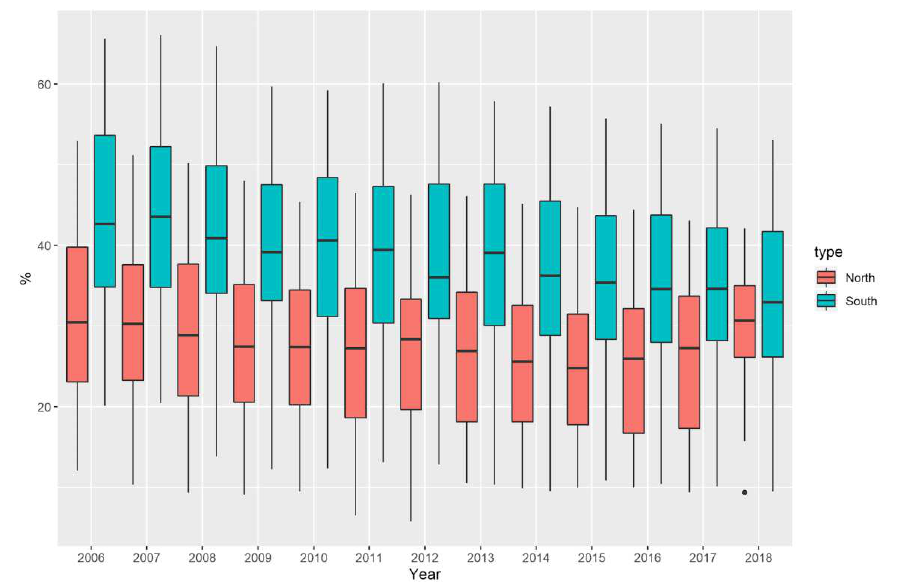
Figure 5. Current debt-to-total assets ratio